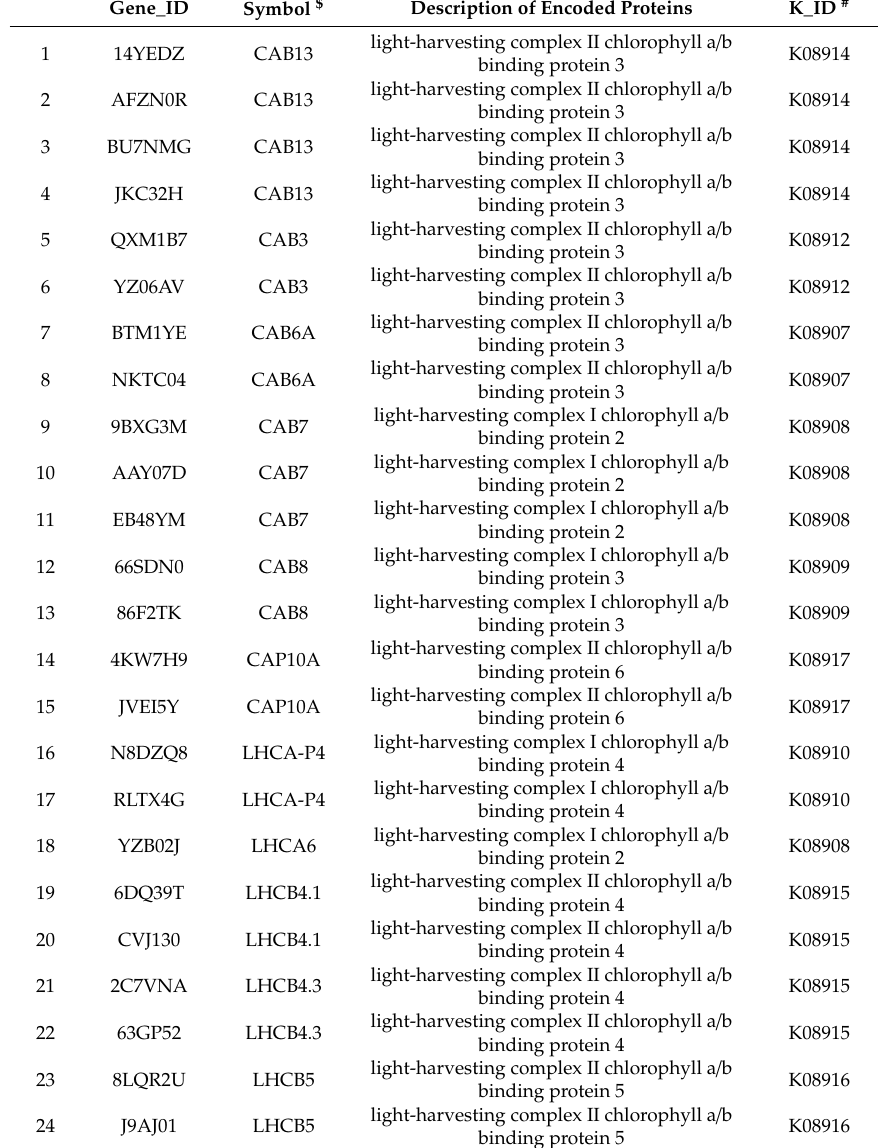
Table 3. The shade stress-induced DEGs encoding light-harvesting chlorophyll